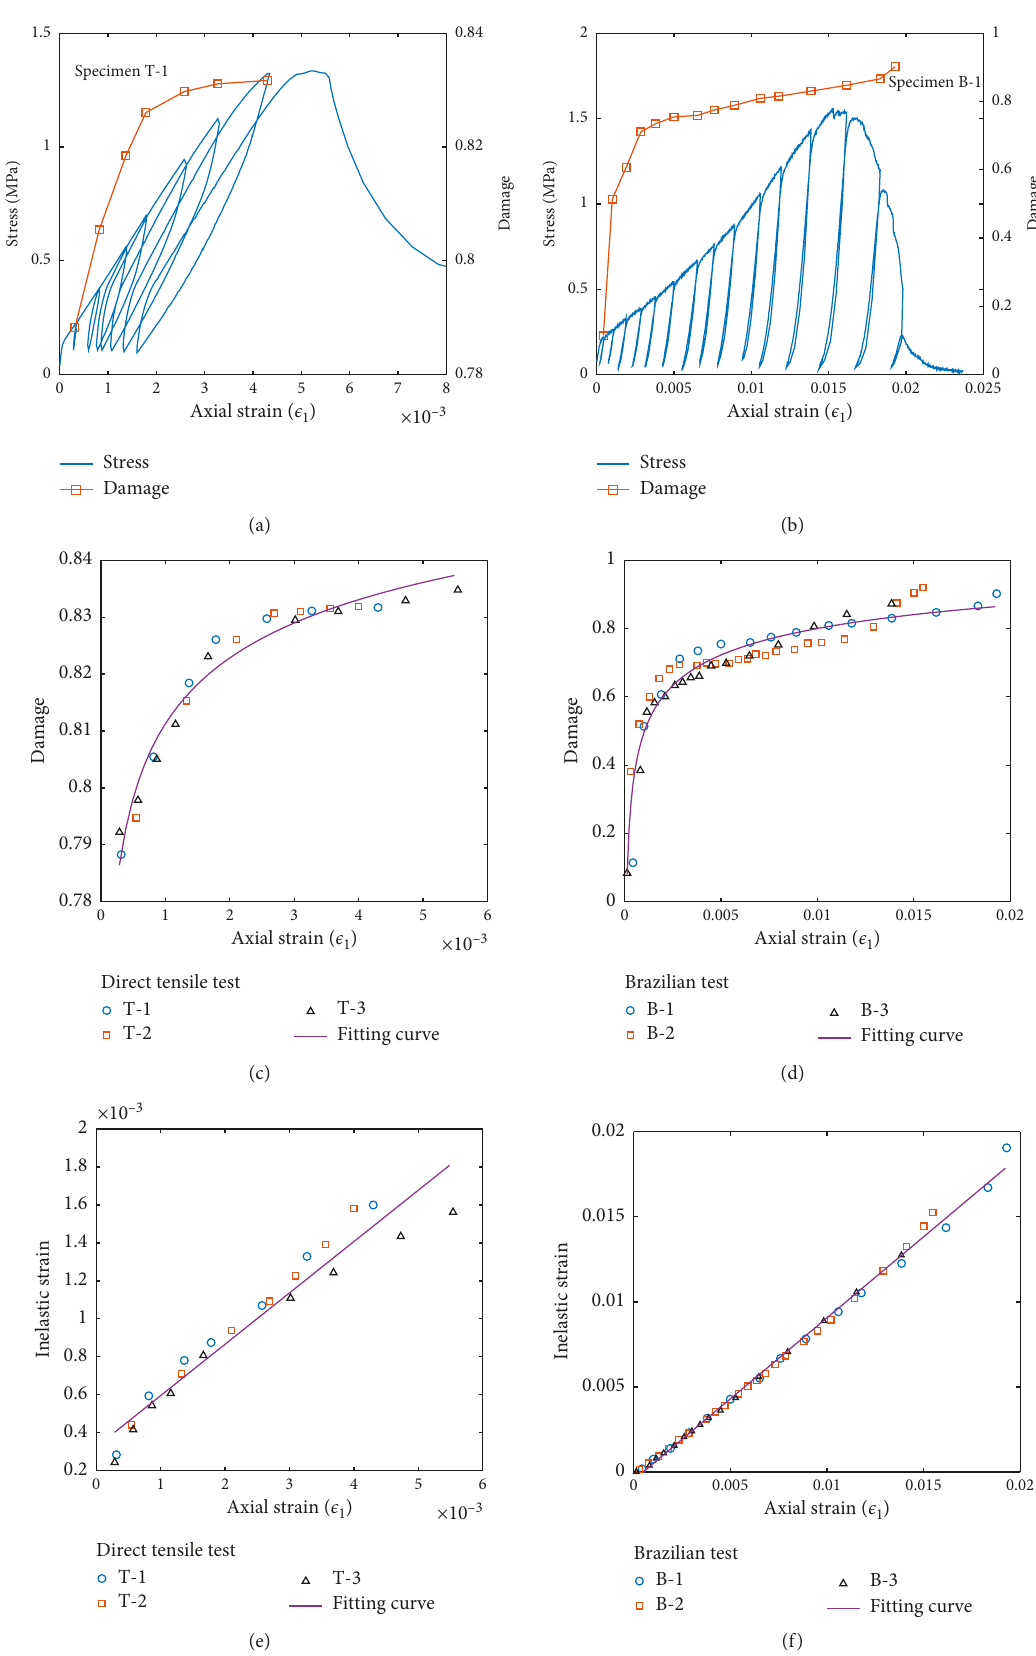
Figure 2: Stress-strain curves and the evolution process of damage and inelastic strain during the direct tensile test and Brazilian